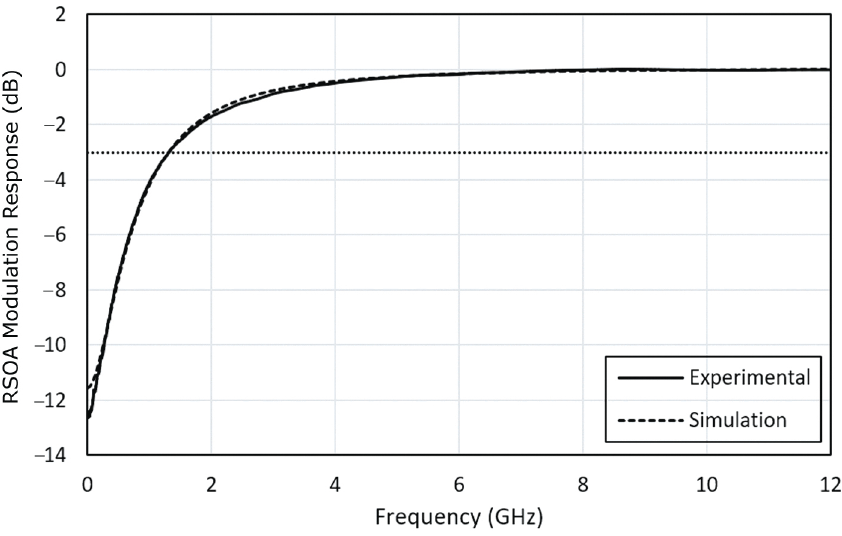
Figure 2. RSOA frequency response: experimental (solid line) and theoretical curve (dashed line). The dotted line denotes the 3 dB bandwidth.